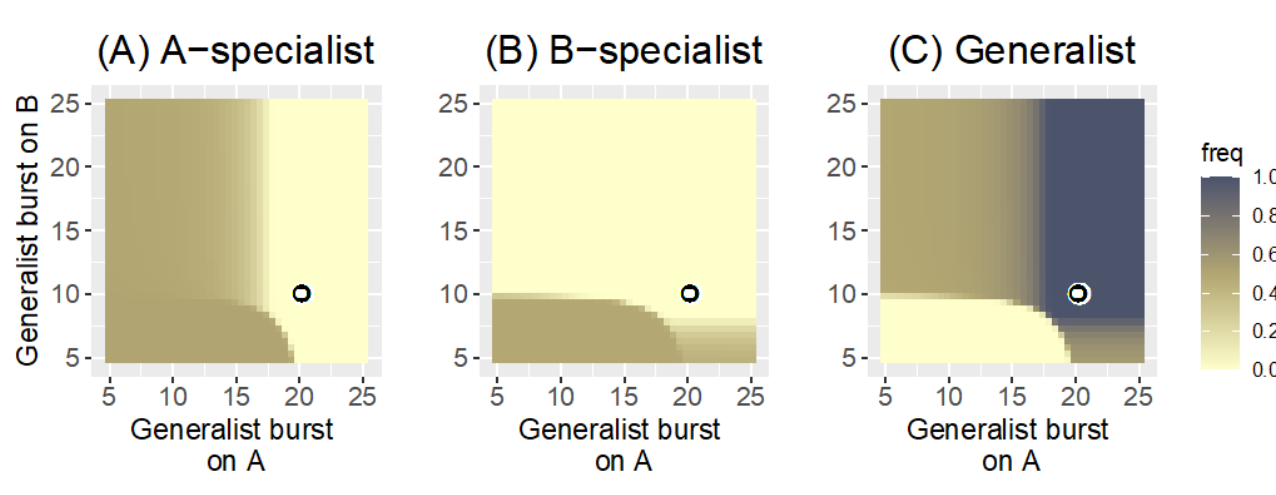
Figure 7. Trials of Parallel presentation under the same conditions as in Figure 4 (bacterial growth rate r = 0.1, fixed-count dilution), except that the phage pool from each host is diluted to density 1000 in each culture separately before being combined into a common pool. The three panels show the frequency of the of the A-specialist ( A ), the B-specialist ( B ), and the generalist ( C ) after 1000 time steps. In contrast to the pattern with fixed-count dilution and low bacterial growth in Figure 4, the pattern with separate dilutions is now similar to that with high bacterial growth rate ( r = 0.3, Figure 3), although the generalist enjoys somewhat more of an advantage here than in Figure 3. Burst sizes of the two specialists are again given by the coordinates of the black-on-white ring. The key is the same as in Figures 2 and